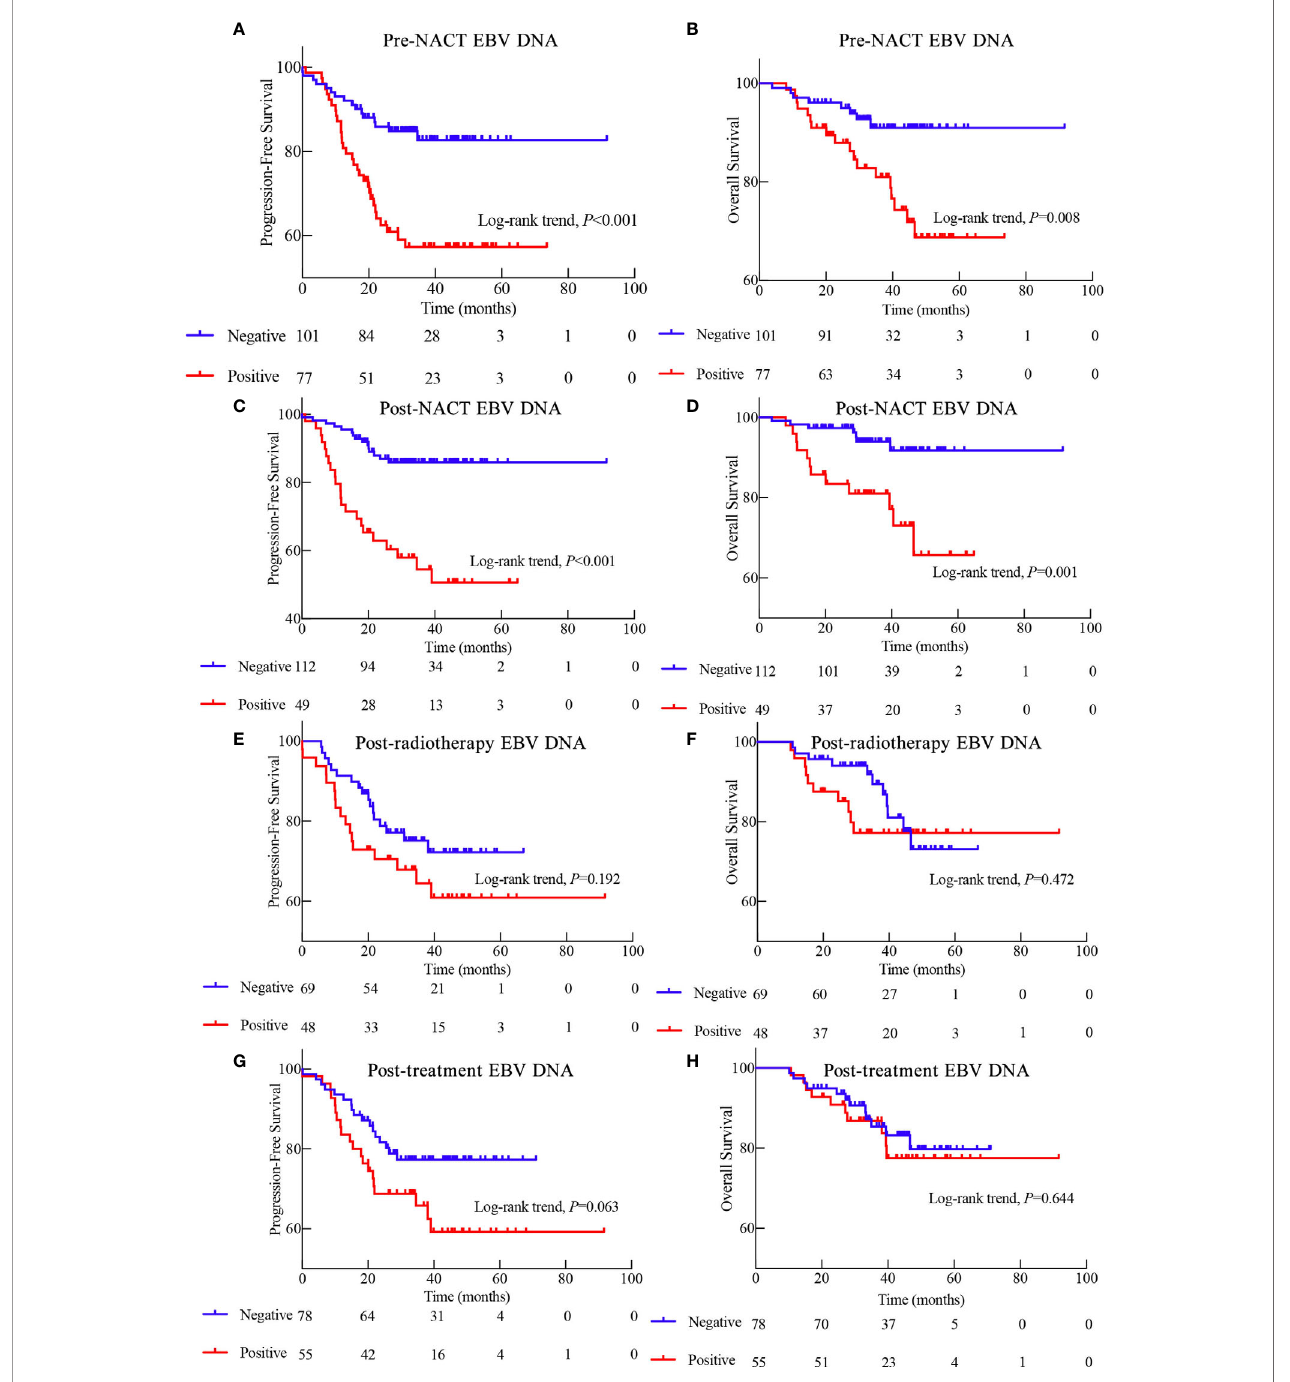
FIGURE 2 | Kaplan-Meier survival curves showing the progression-free survival (PFS) and overall survival (OS) of patients with EBV tested during different stages of treatment. (A) PFS based on pre- neoadjuvant chemotherapy (NACT) EBV DNA levels. (B) OS based on pre-NACT EBV DNA levels. (C) PFS based on post-NACT EBV DNA levels. (D) OS based on post-NACT EBV DNA levels. (E) PFS based on post-radiotherapy EBV DNA levels. (F) OS based on post-radiotherapy EBV DNA levels. (G) PFS based on post-treatment EBV DNA levels. (H) OS based on post-treatment EBV DNA